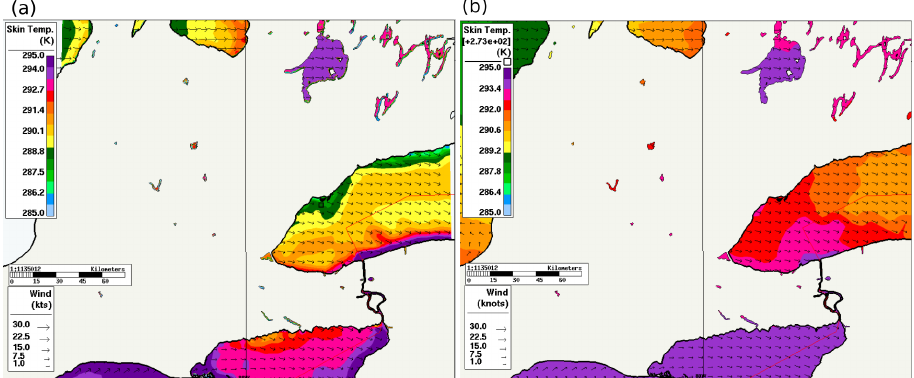
Figure 6. Comparison of water surface temperature (inK) and near-surface wind vectors (inknots) on 23 July 2015 0200EDT (0600UTC) over the inner domain between ( a ) TOR-GEM250 (with the PanAm downtown buoy located with the square and filled with the corresponding measured value), and ( b ) the 10-km operational analysis. Vectors are displayed based on the figure pixels and a mask covers the land surface for the sake of